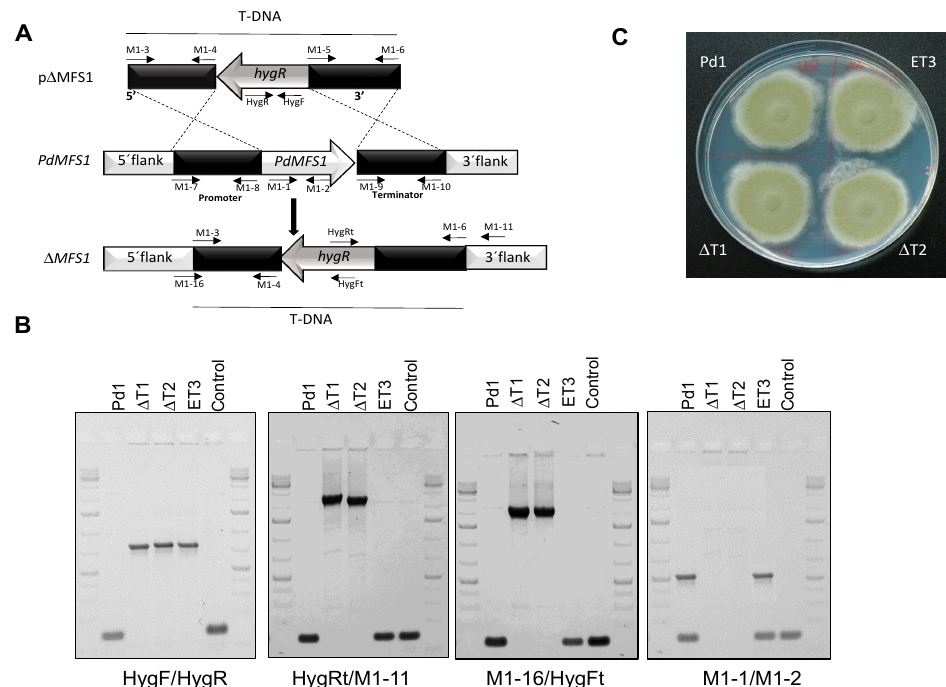
Figure 2. ( A ) Diagram of wild-type locus and the PdMFS1 replacement with the HygR selectable marker from p ∆ MFS1 by homologous recombination to generate the ∆ MFS1 mutants; ( B ) Polymerase chain reaction (PCR) evaluation of the wild-type Pd1 strain, two ∆ PdMFS1 null mutants ( ∆ T1, ∆ T2) and the respective ectopic mutant (ET3) with analytic primers. ( C ) Phenotypical traits and conidiation. Fungal strains grown in potato dextrose agar (PDA) plates at 25 °C during six days.